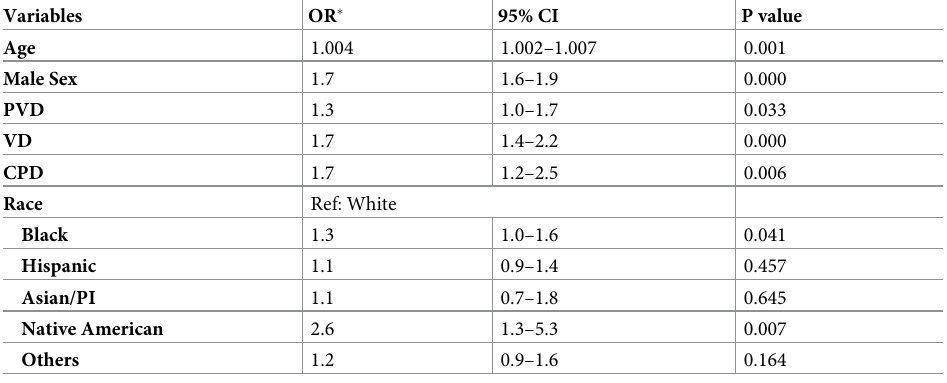
Table 4. Multivariable logistic regression: Predictors of Lyme carditis in patients hospitalized with Lyme disease in the U.S. between 2003 and